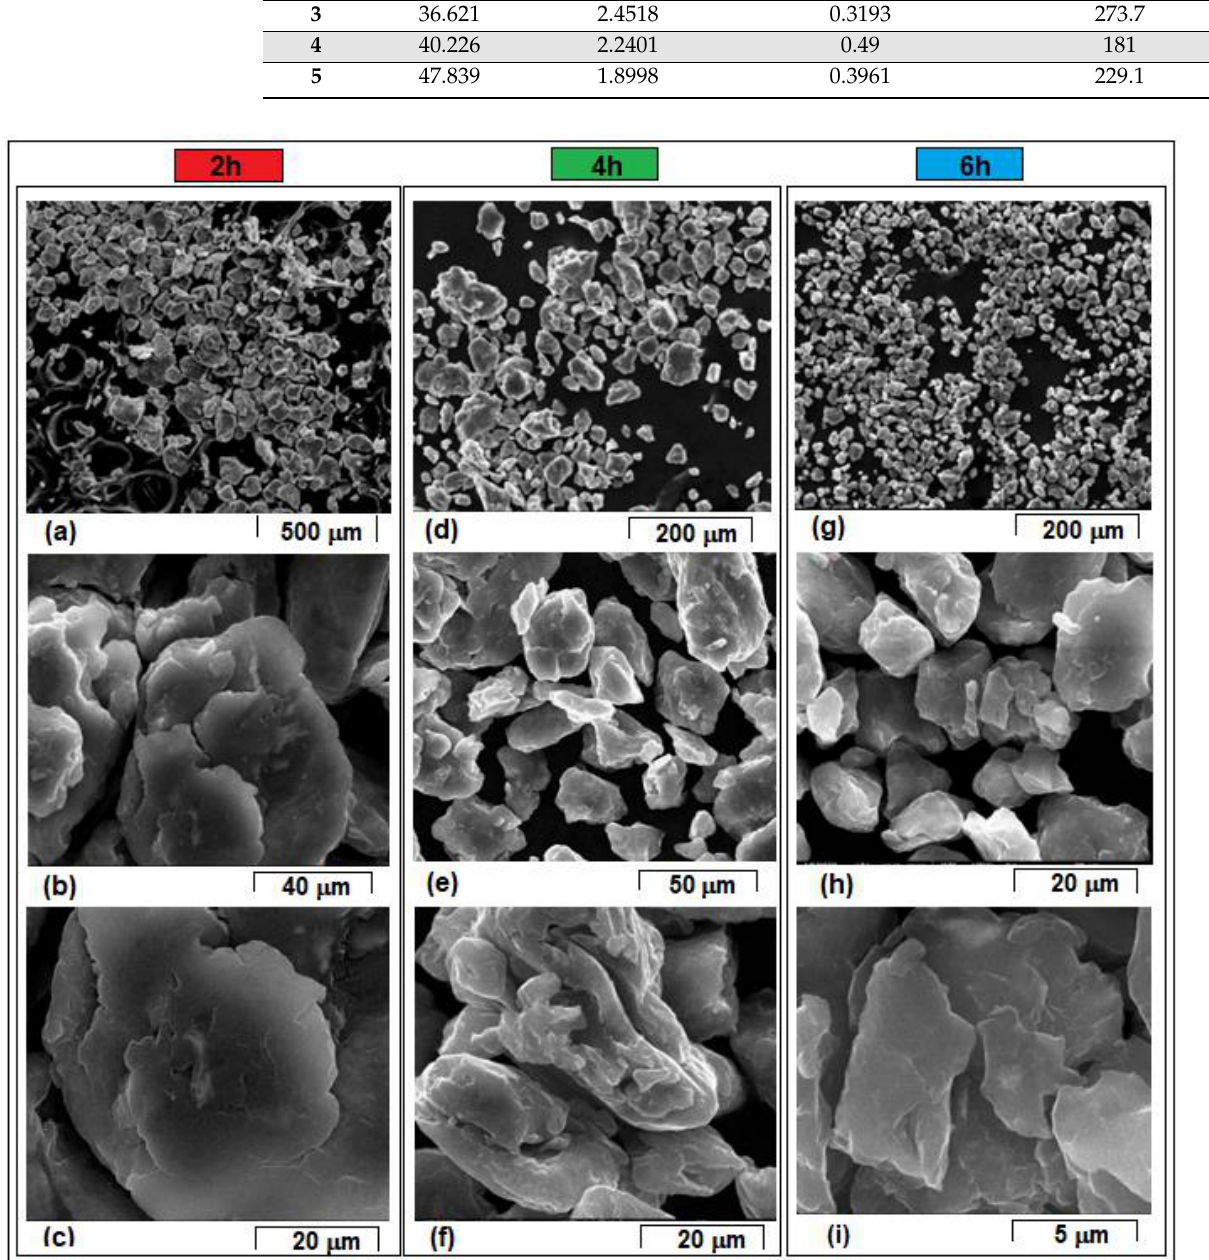
Figure 5. SEM images of the powder-alloy samples processed by mechanical alloying for different milling time: ( a – c ) 2 h/300 rpm, and different magnifications; ( d – f ) 4 h/300 rpm, and different magnifications; ( g – i ) 6 h/300 rpm, different magnifications;